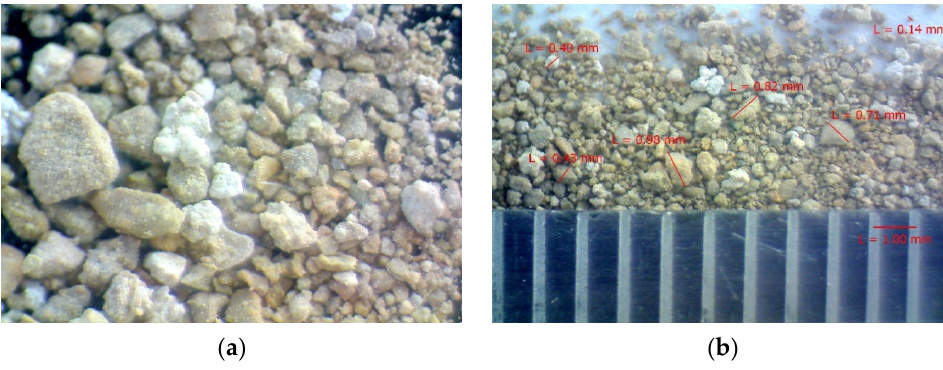
Figure 2. General view of the OS particles. Magnification: ( a ) ×100, ( b ) ×50.